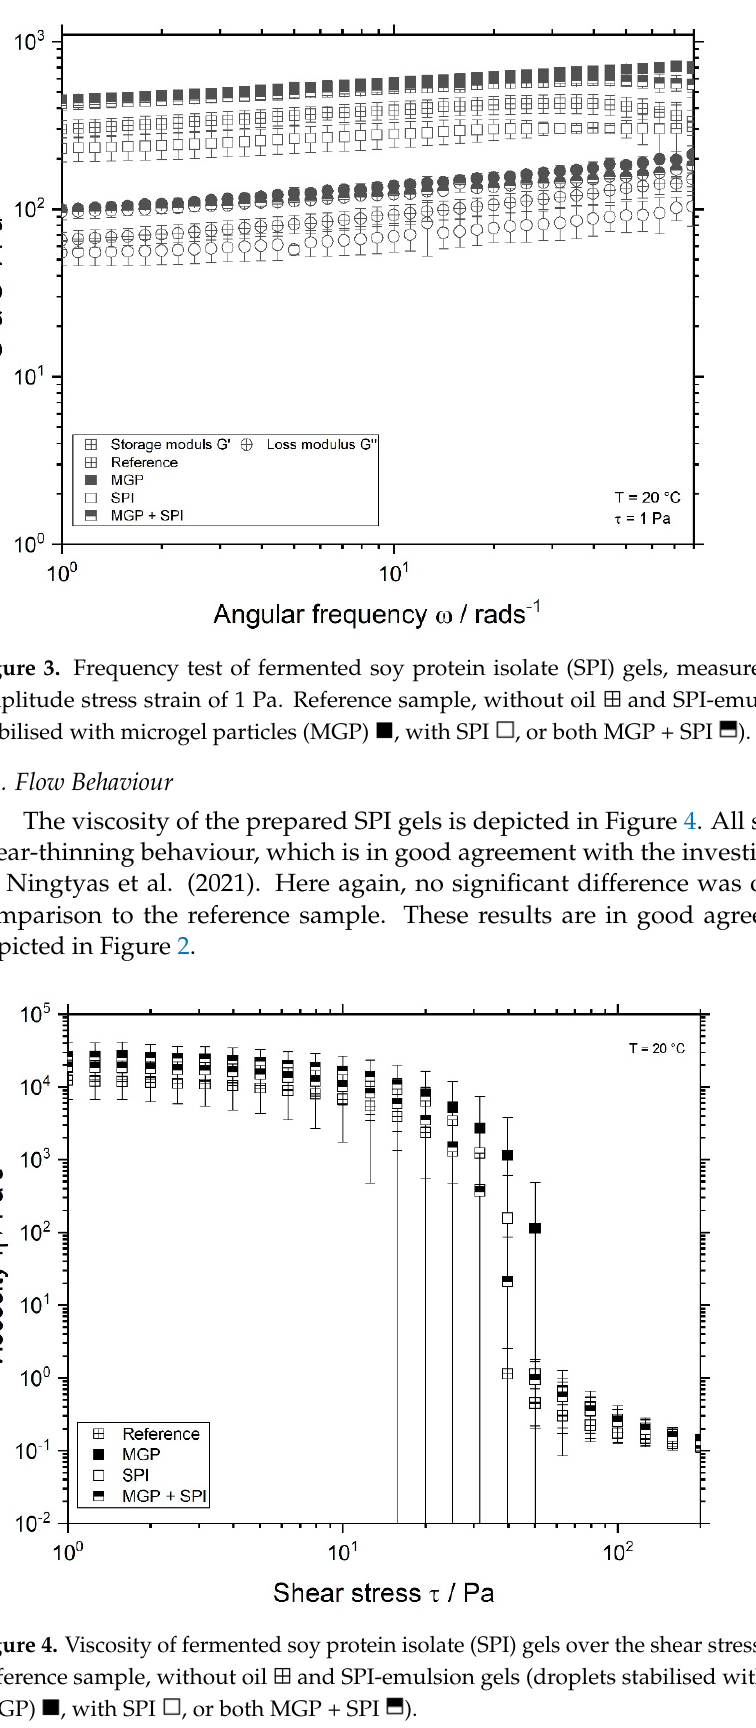
Foods 2022 , 11 , x FOR PEER REVIEW 7 of 16 the linear viscoelastic region (LVE) of SPI gels. Softer materials should sustain greater strain stress than densely packed materials [32]. The maximal stress within the LVE, 𝜏 (cid:3040)(cid:3028)(cid:3051) , is determined by the gel’s strength. An increase of stress strain beyond 𝜏 (cid:3040)(cid:3028)(cid:3051) leads to changes in the elastic and viscous behaviour of the samples [33]. The effect that the addition of fibre and fat has on the gel properties depends on the type and extent of the interactions between these components and SPI [34]. It was expected that the addition of fibre in form of microgel particles and fat would affect the length of the LVE of the SPI- gels compared to samples without these components [8,20,22]. However, as seen in Figure 2, amplitude tests show no difference between the samples.